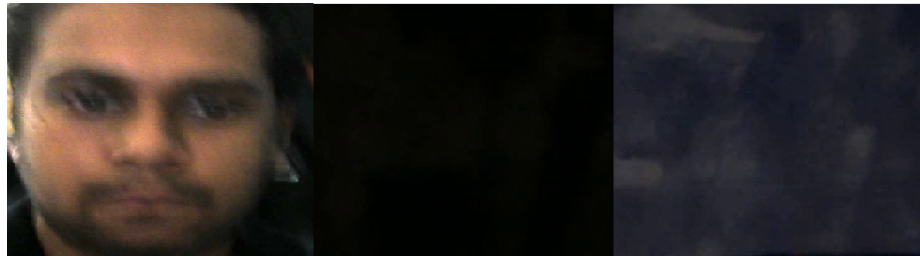
Figure 10. Samples indicating cases where the face detector failed to extract the face